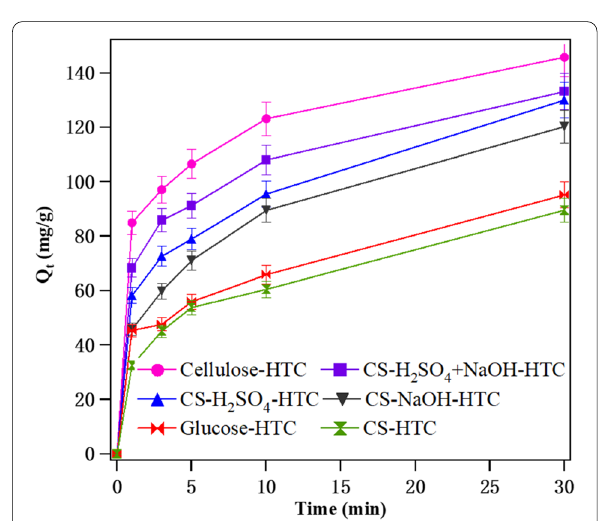
Fig. 6 MB uptake ( Q t ) versus time of CS hydrochars, glucose and cellulose-derived hydrochars. Adsorption conditions: MB